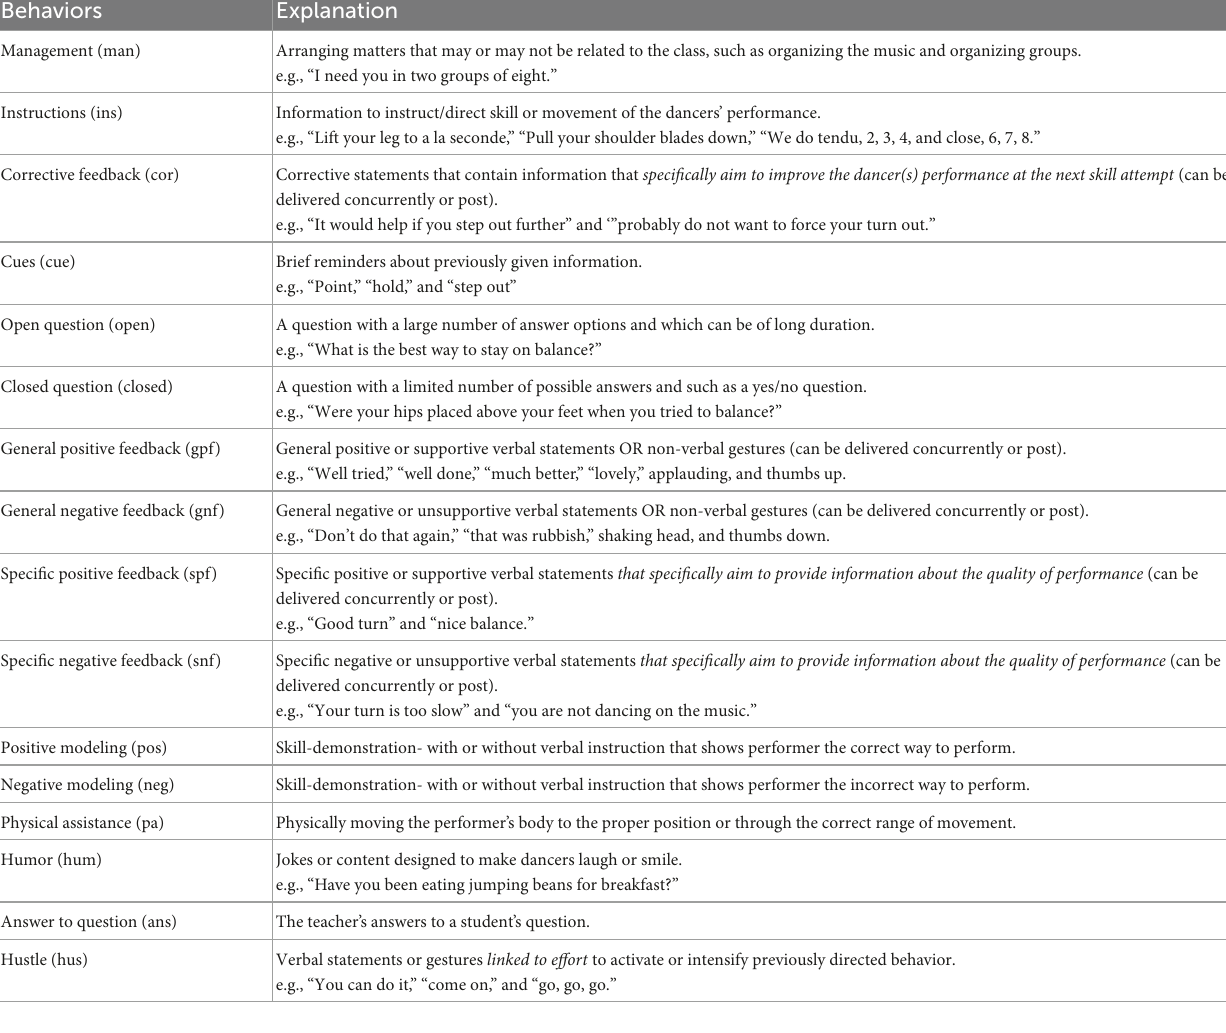
TABLE 1 Overview of the adapted coach analysis and intervention system. Behaviors Explanation